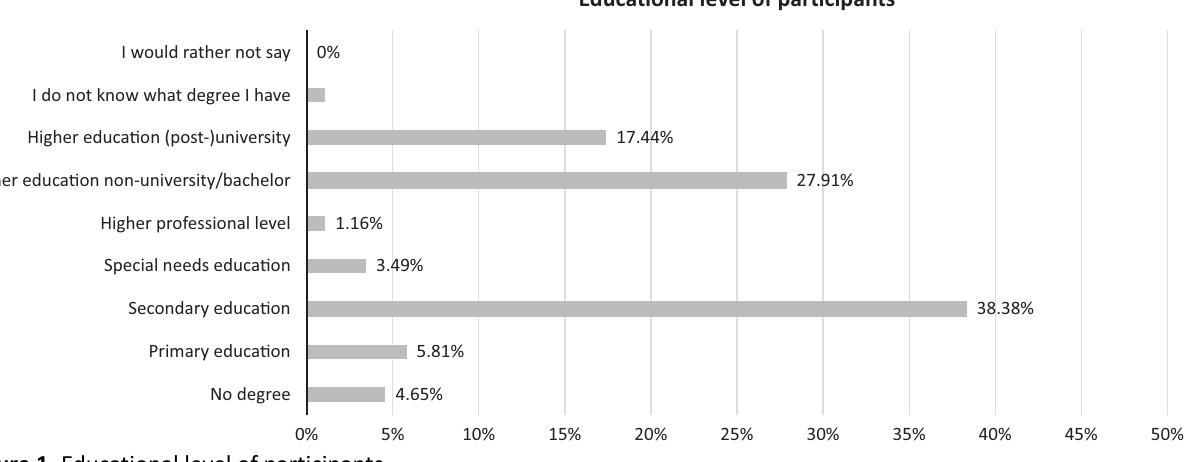
Figure 1. Educational level of